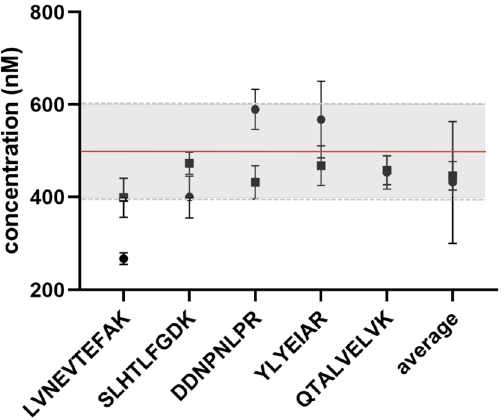
Figure 5. The comparison of the quantitative performance of SIL-ExC3N3 (filled circle) and SIL-HSA (filled square). HSA concentration determined by reference methods (500 nM) indicated as a red line; the grey area represents 20%